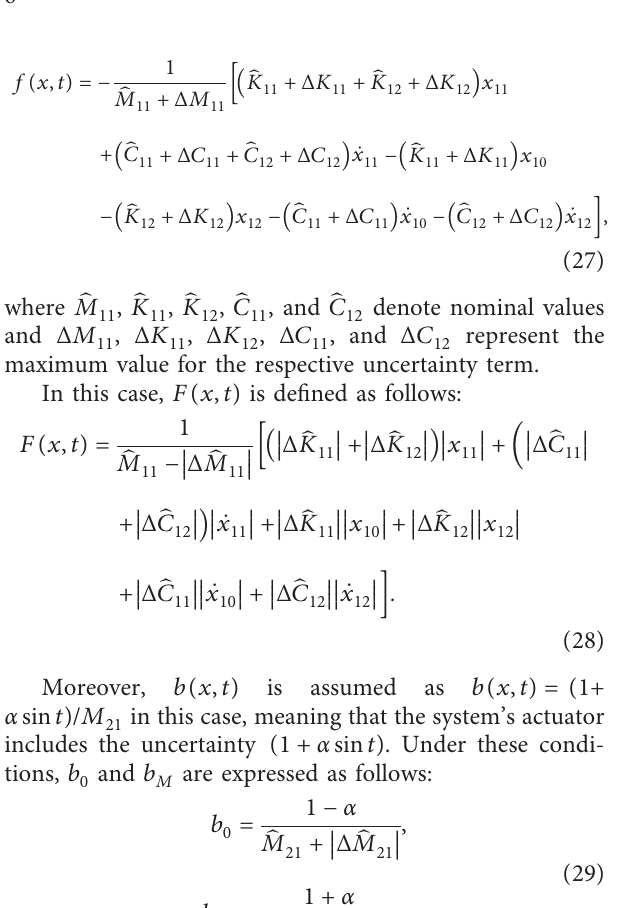
Figure 2: The resulting horizontal displacement for 11 th story controlled and uncontrolled cases.